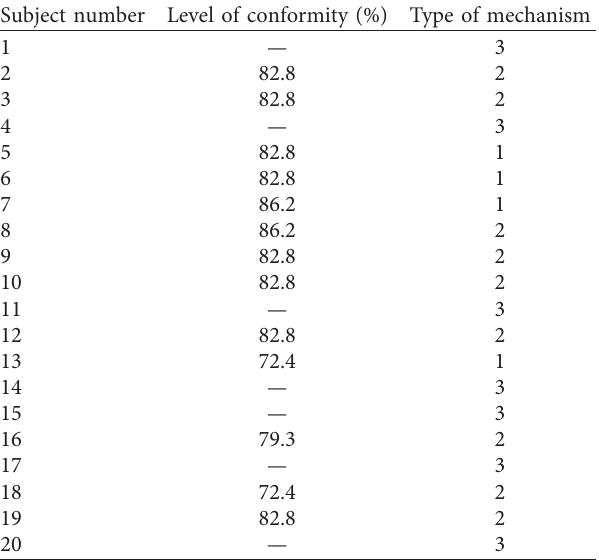
Table 13: Route-choice mechanism for subjects. Subject number Level of conformity (%) Type of